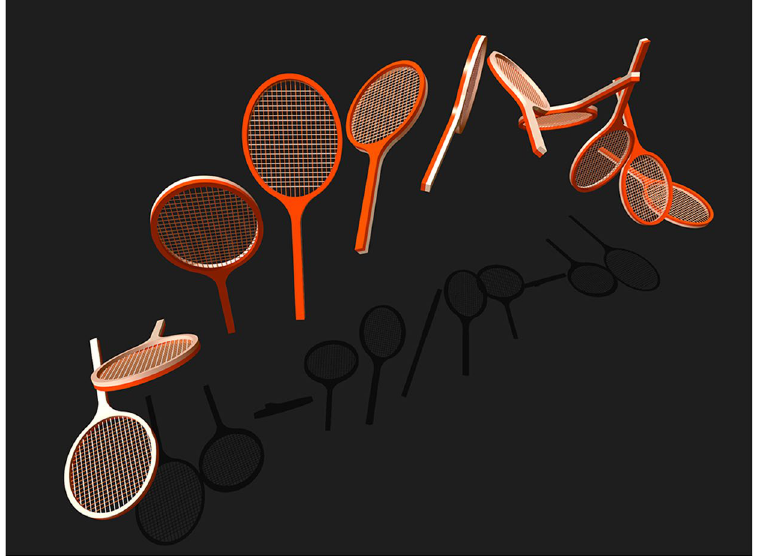
Figure 1. The tennis racket effect. Illustration of the motion of the tennis racket. Note the flip of the head when the handle makes a 2 π